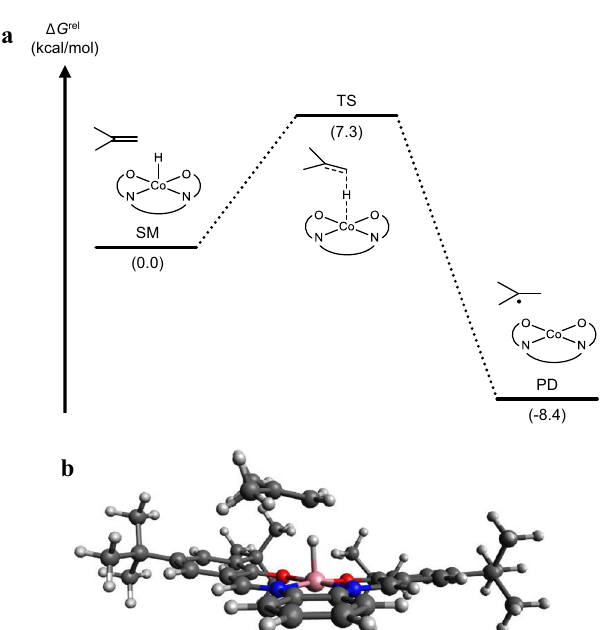
Fig. 5 HAT pathway elucidated by quantum chemical calculations. a Computed energy diagram of the HAT between cobalt(salophen) hydride complex and isobutene. b Computed structure of the transition state of the HAT between cobalt(salophen) hydride complex and isobutene; Δ G rel relative free energy, SM starting materials, TS transition state, PD products. See the Supplementary Information for computational details.